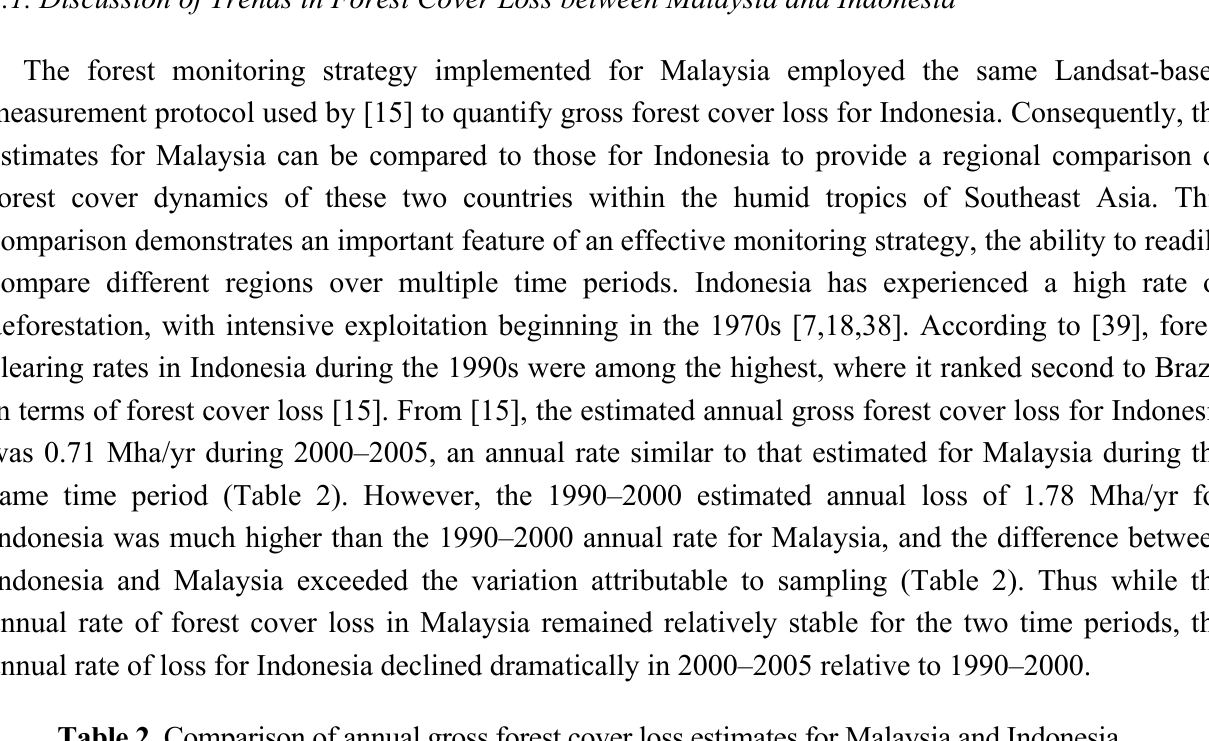
Table 2. Comparison of annual gross forest cover loss estimates for Malaysia and